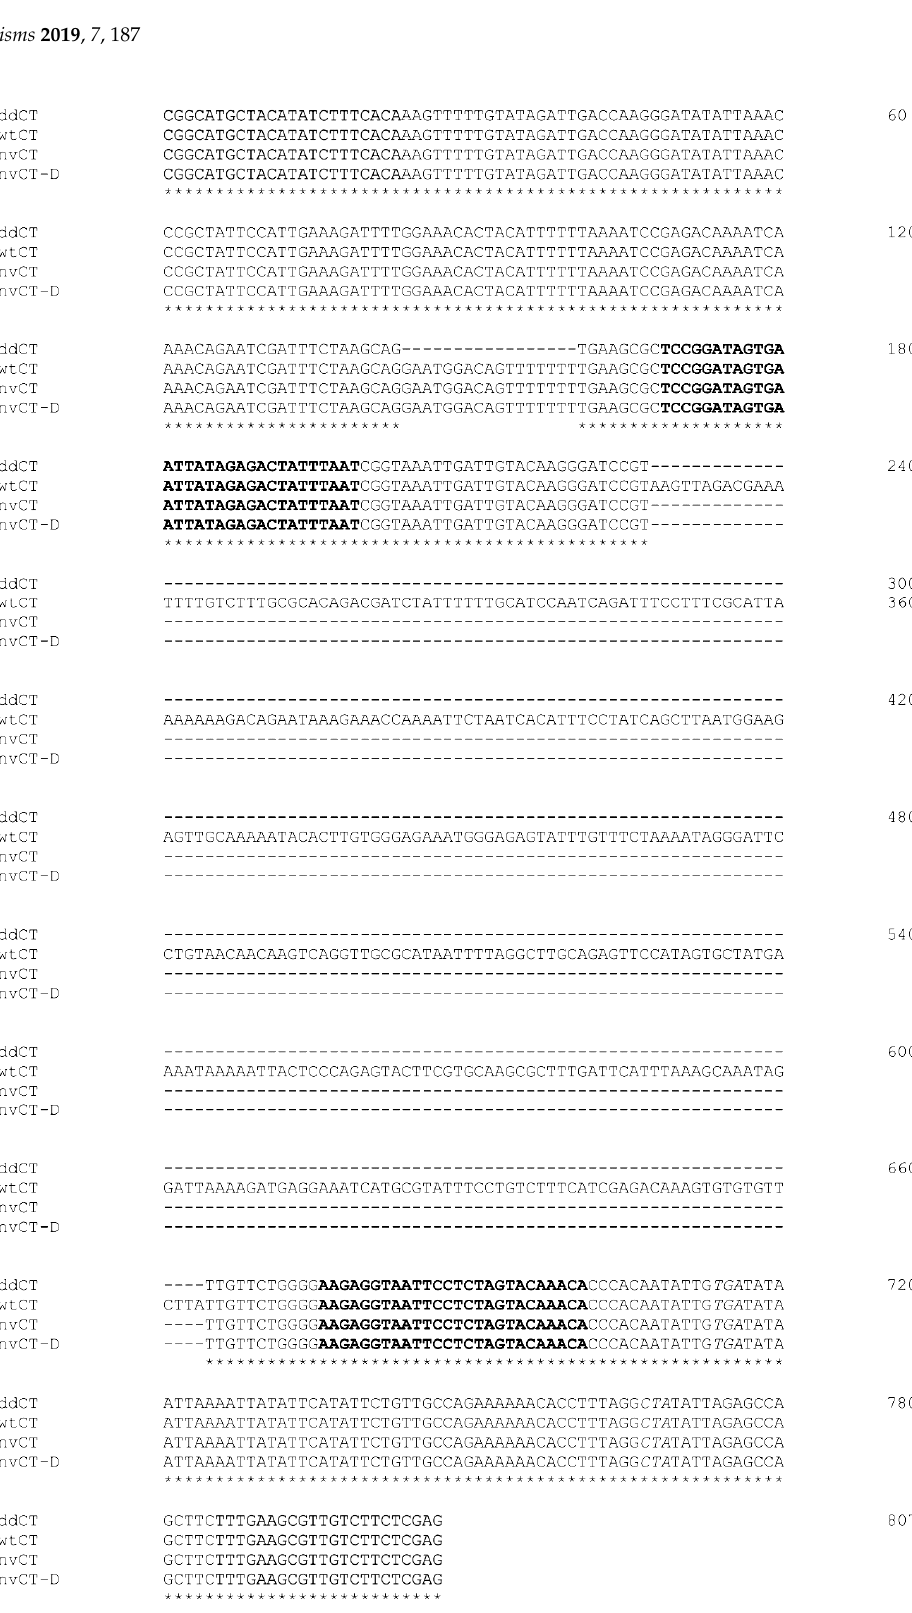
Figure 1. Alignment of the orf1 of the cryptic plasmid of C. trachomatis for wtCT, nvCT and nvCT-D with the partial corresponding sequence of the case-patient sample from urethra (ddCT) amplified with primers gB_swCT-F / R (highlighted). Stop codons for the orf1 (TGA) and orf2 genes (TAG, in complementary chain) are in italic. The primers swCT_serE-F / R flanking the 377 bp deletion in the nvCT strain are in bold. The sequence of the case-patient contains both 17-bp and 377-bp